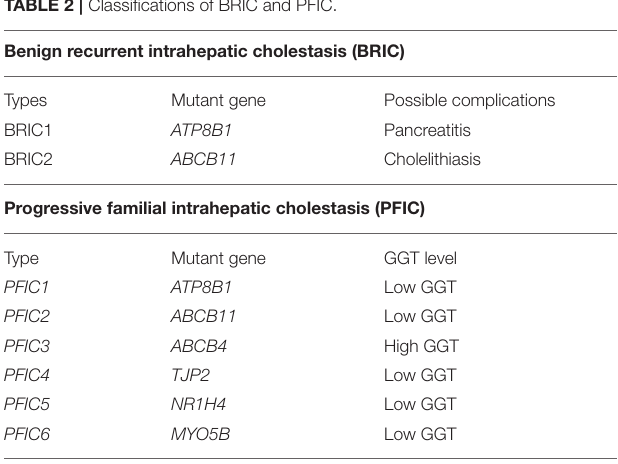
TABLE 2 | Classifications of BRIC and